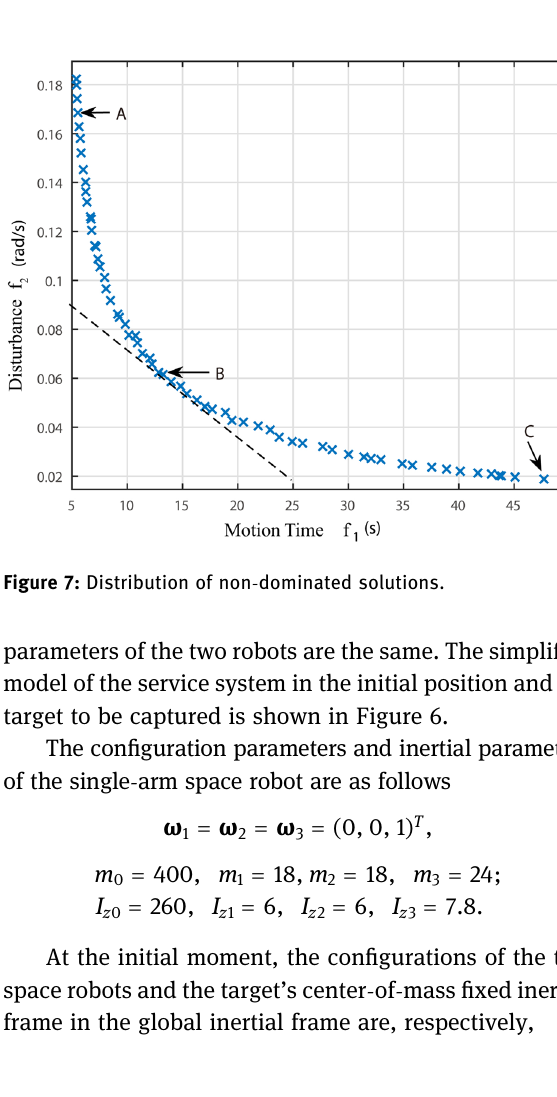
Figure 6: The simpli fi ed model of the service system in the initial position.